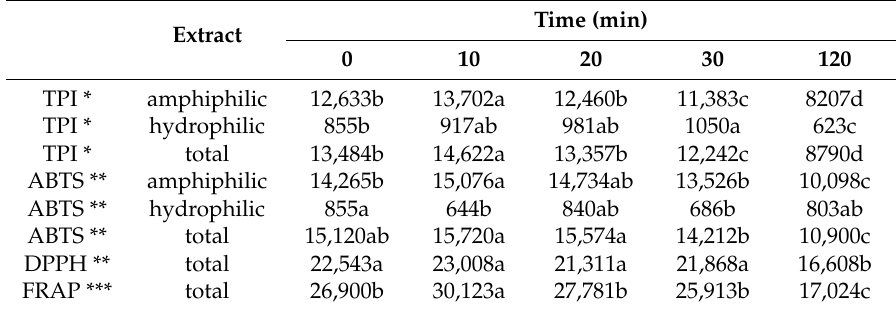
Table 3. Total phenolic content (TPI) and antioxidant activity ( µ mol kg − 1 f.w.) of Pink Lady apples, as affected by plasma treatment